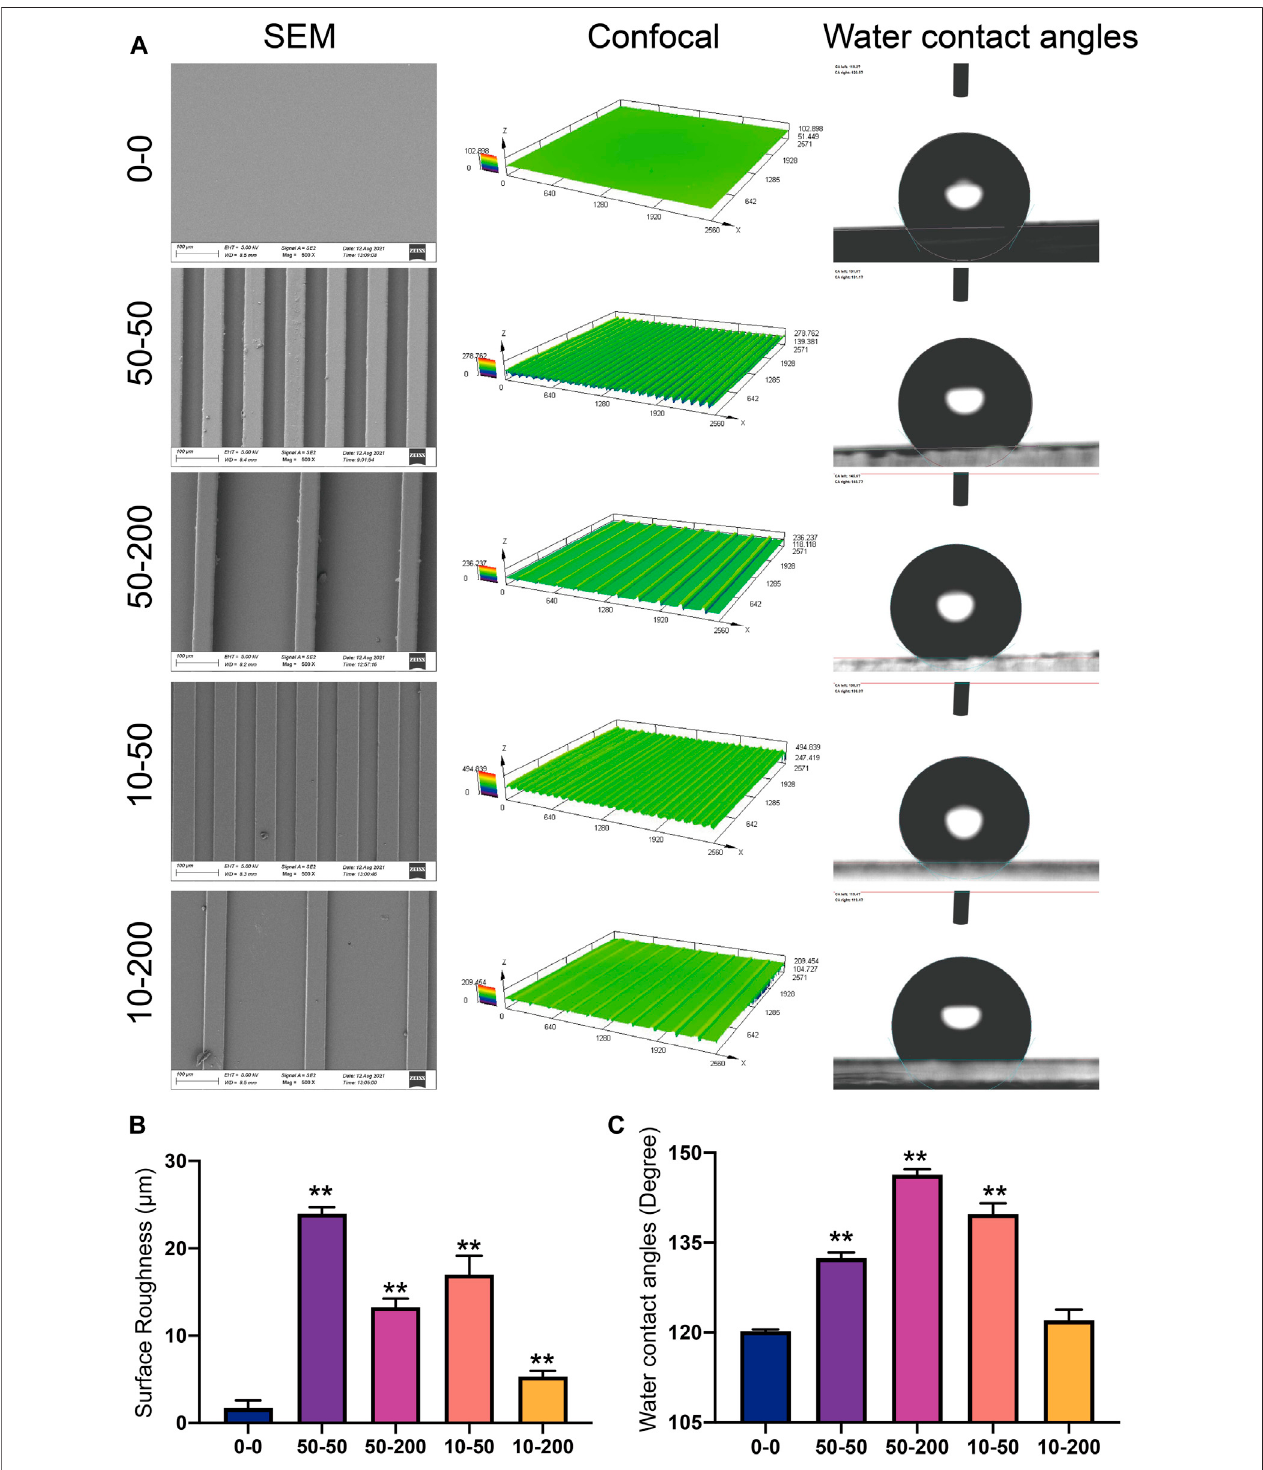
FIGURE 2 | Surface characterization. (A) Representative images of a scanning electron microscope, laser confocal microscope, and water contact angle. (B) Statistical analysis of surface roughness (Sa) measured using a laser confocal microscope. (C) Statistical analysis of the water contact angle. Data comparisons were implemented utilizing one-way ANOVA, and the values are expressed as mean ± standard deviation (SD). n (cid:2) 3, ** p < 0.01 vs 0 – 0.